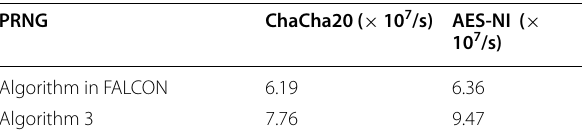
Table 4 Number of exponential Bernoulli samples per second